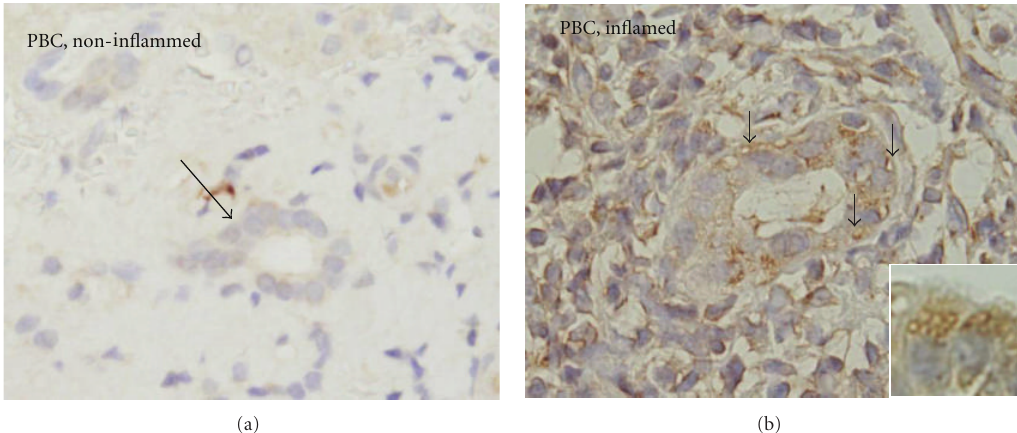
Figure 3: Biliary epithelial autophagy in PBC. (a) The expression of autophagy marker LC3 was not observed in BECs in noninflammed bile ducts (arrow) in PBC. (b) The expression of autophagy marker LC3 was detected in intracytoplasmic vesicles (arrows) in BECs involved in inflamed and damaged small bile ducts in PBC. Immunostaining for LC3. Original magnification, × 400 (inset, × 1000).